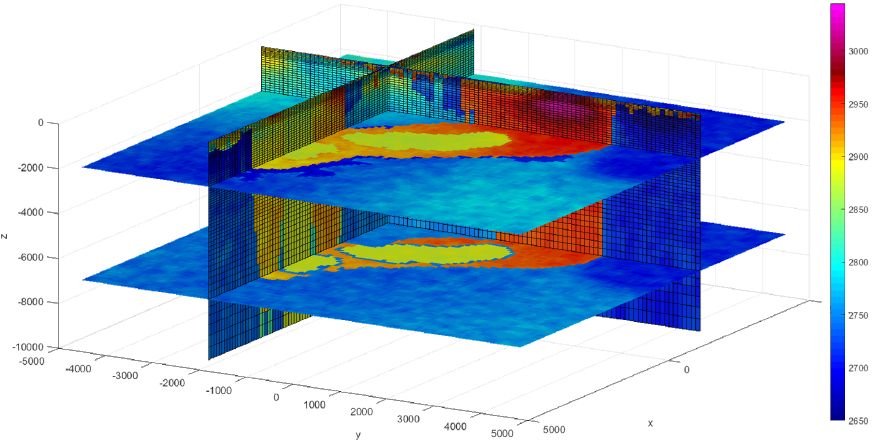
Figure 7. Estimated 3D density model. Units are kg/m 3 .